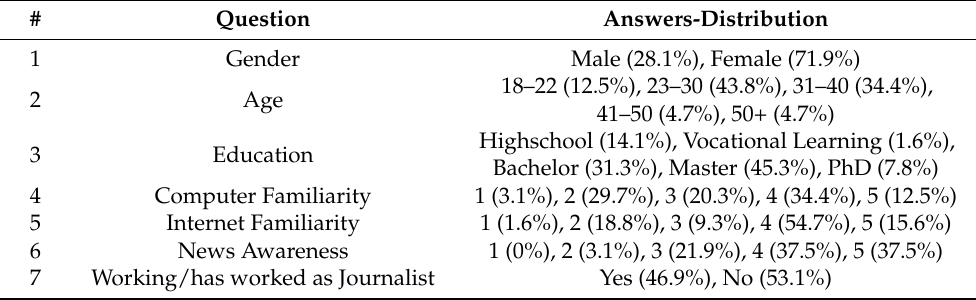
Table 4. Demographic Information of